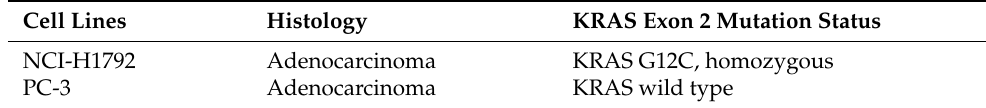
Table 1. Cell lines used for validation. The name of the cell line, tumor type, and the mutation status are shown. NCI-H1792 was used for the experimental cell line, since it contains the target KRAS G12C mutation, and PC-3 was used as the control cell line since it contains wild type KRAS.